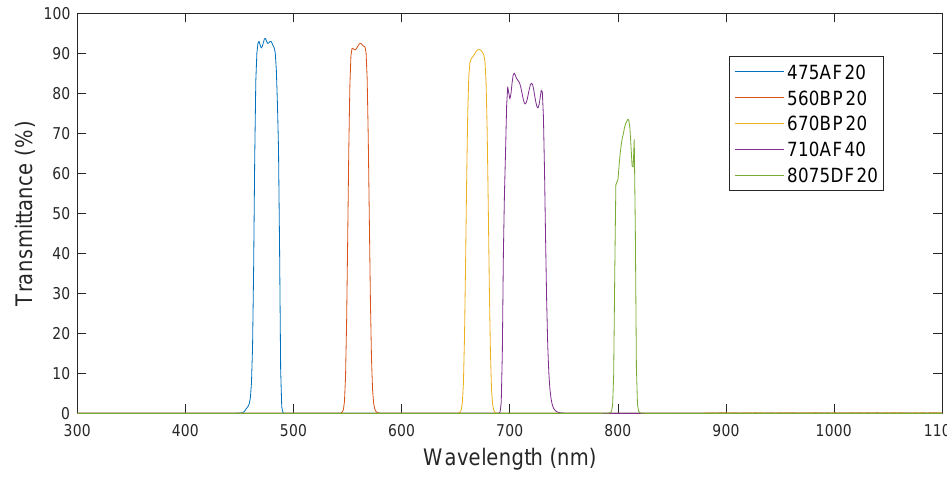
Figure 3. Filter transmittance